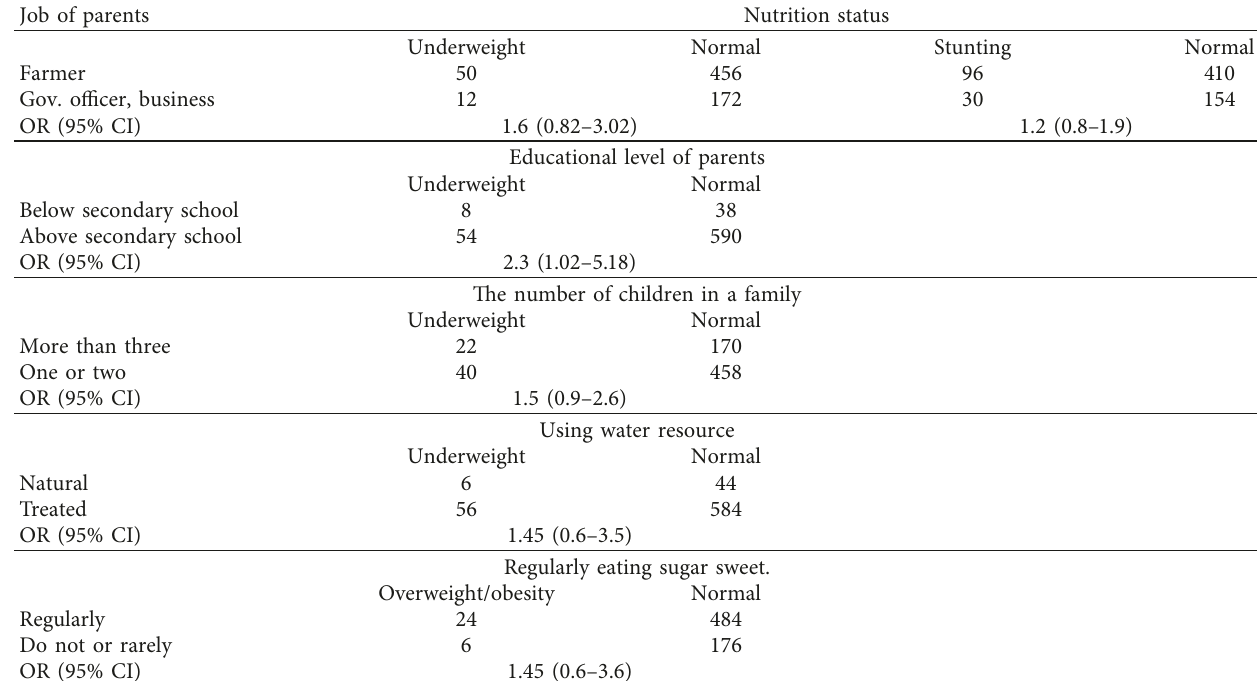
Table 3: Some factors related to nutrition status.